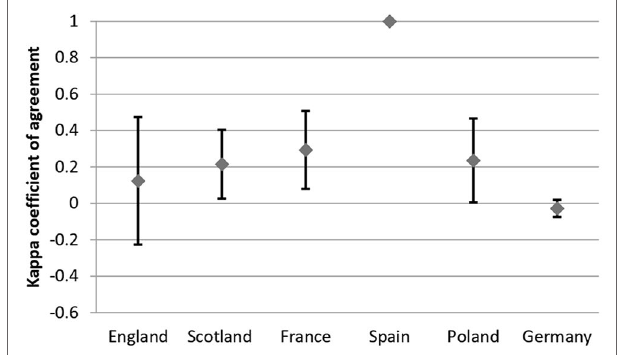
FIGURE 3 | Agreement Between Recommendations and Reimbursement Status—all drugs.